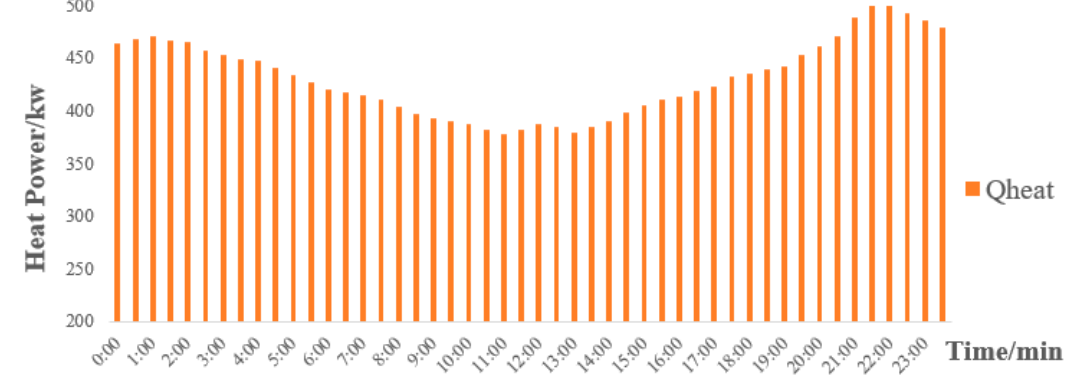
Figure 5. Summer heat load chart.